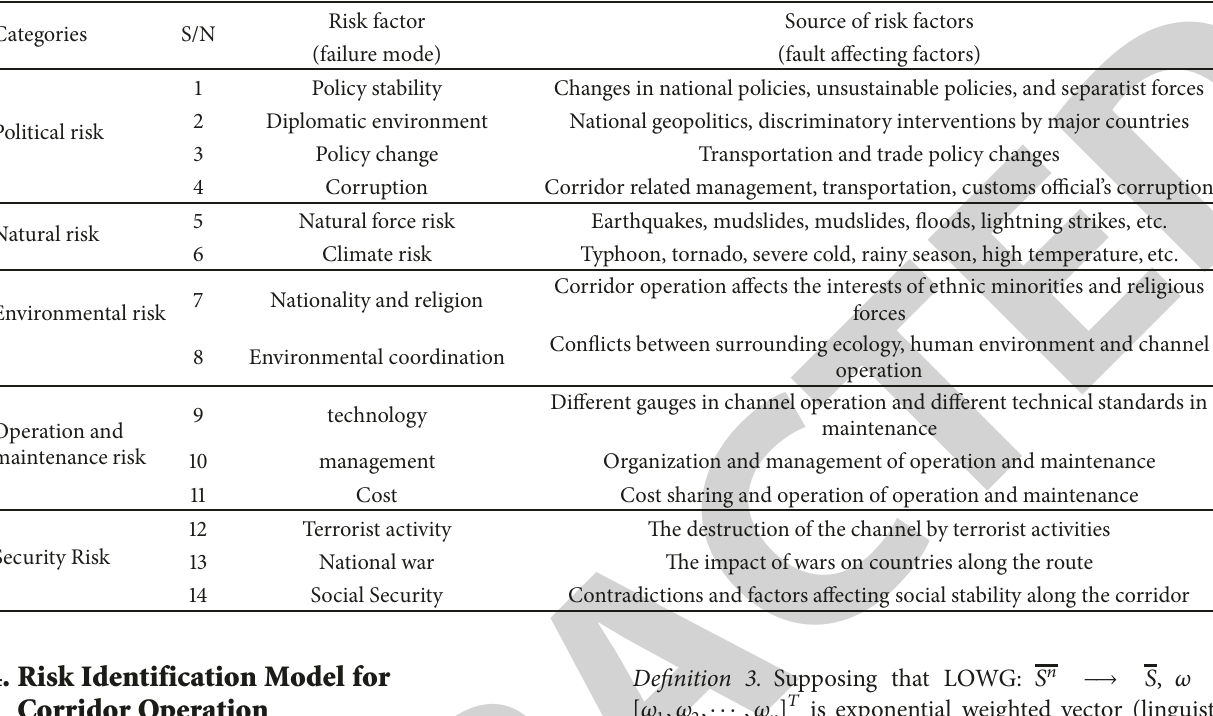
Table 1: Evaluation indicators of risk factors for the operation of